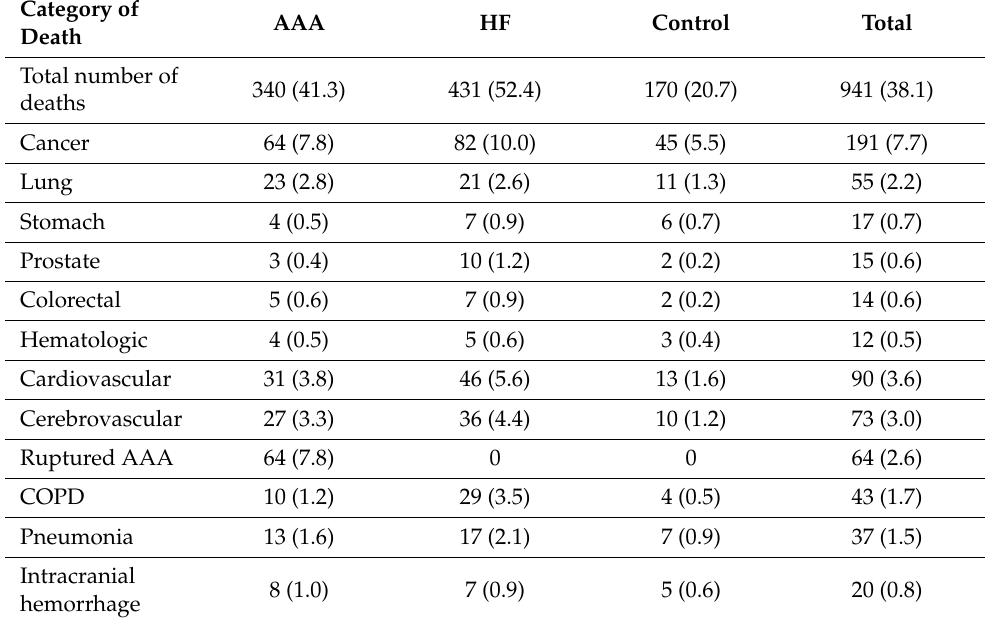
Table 6. Major causes of